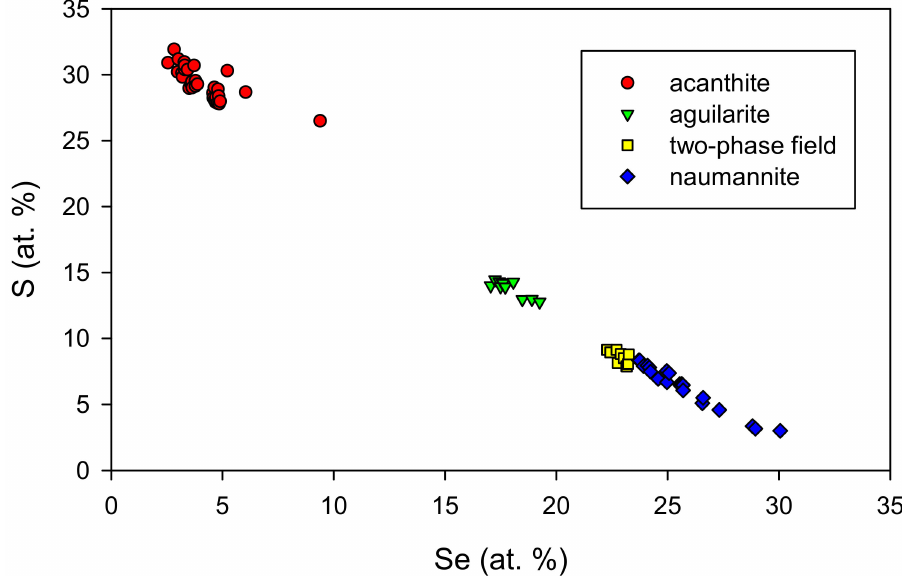
Figure 4. Graph of Se vs. S (at. %) for mineral phases of the Ag 2 S–Ag 2 Se series from the Kremnica deposit.